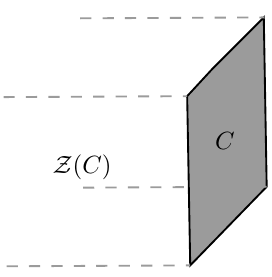
Figure 5 . The bulk TQFT is the Drinfeld center of the spherical fusion category describing the boundary